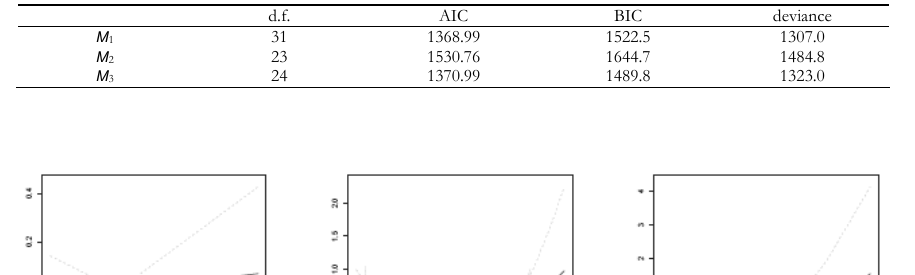
Comparison of ZIP, Poisson and Negative Binomial models: M 1 is the final ZIP model; M 2 and M 3 are, respectively, the Poisson and Negative Binomial models involving all variables included in M 1